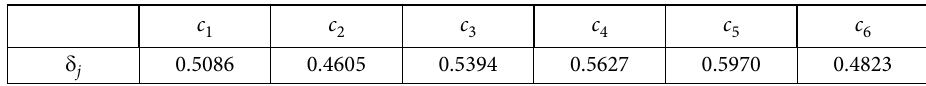
Table 8. Final performance scores of different attributes